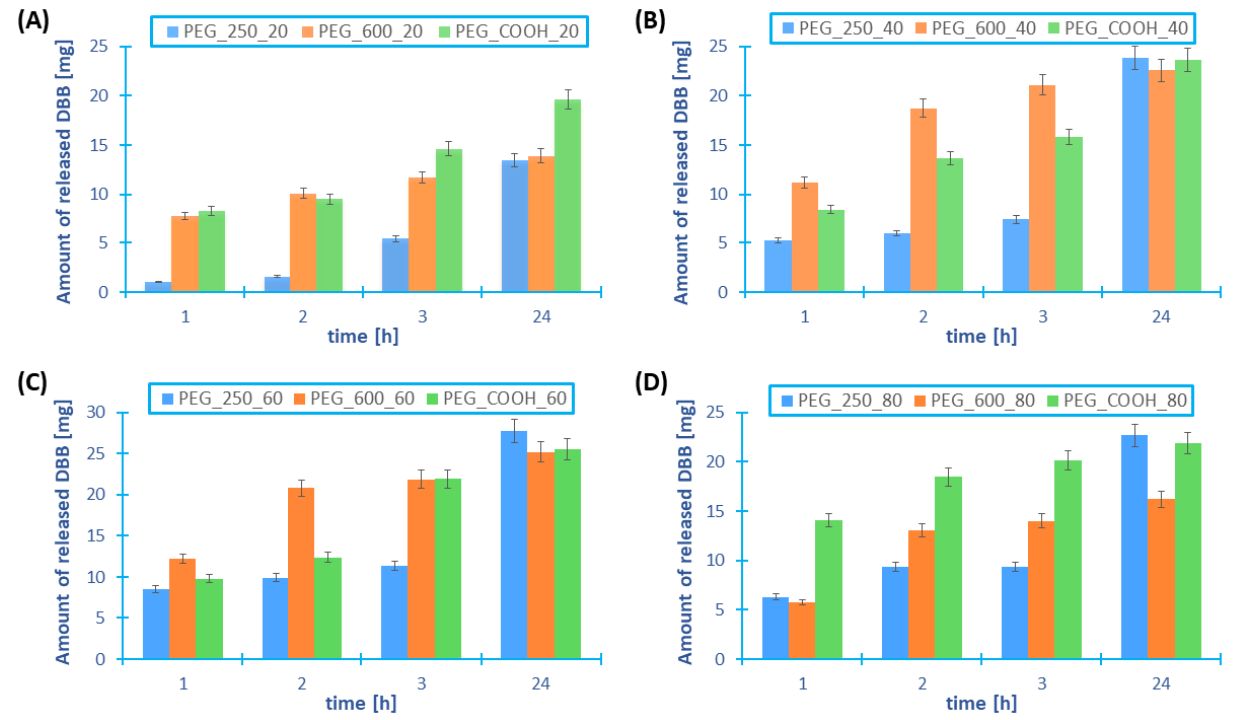
Figure 10. Comparison of the amount of DBB released from branched and linear copolymers, in which the PEG content is, respectively, 20 wt% ( A ), 40 wt% ( B ), 60 wt% ( C ), and 80 wt% ( D ) ( n = 3, error bars, standard deviation).